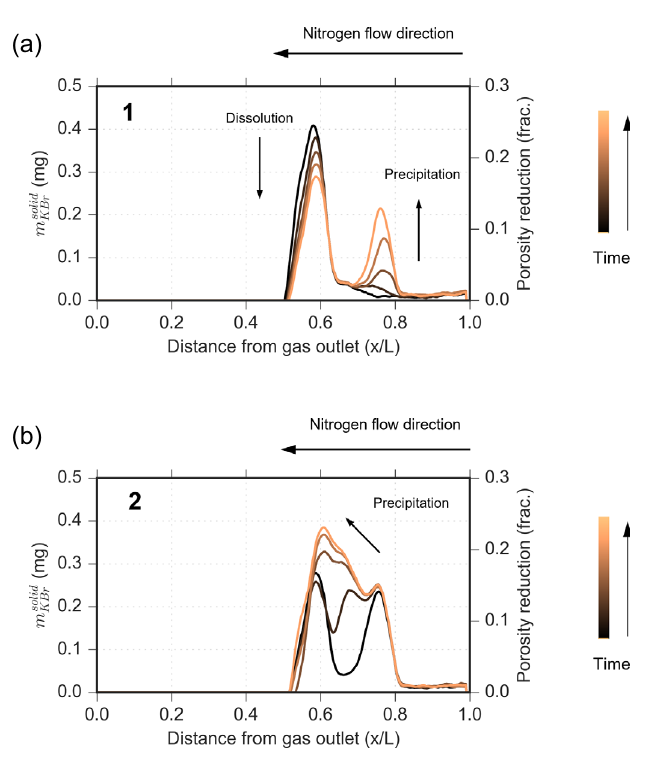
Fig. 14. Precipitated salt pro fi les during (a) a gas draw-down (see cycle 1 in Fig. 12) and (b) a gas build-up (see cycle 2 in Fig. 12). The mass of salt is given for a pixel volume of 6.67 (cid:1) 10 (cid:3) 4